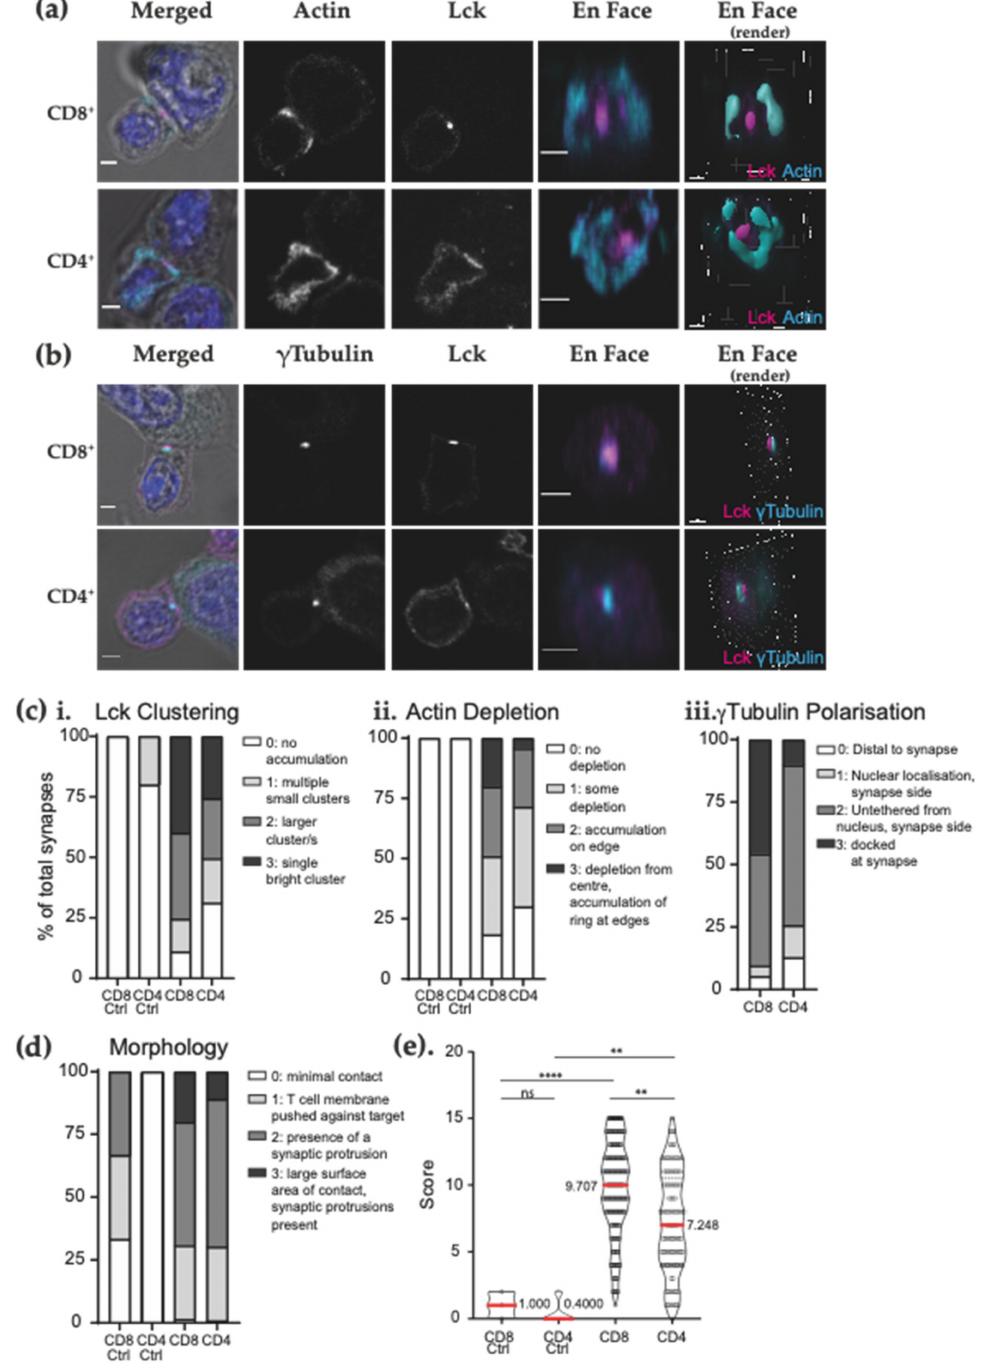
Figure 4. GCT615-CAR T cell target conjugates synapses show topological similarity to physiological immune synapses. CD4 + or CD8 + GCT615-CAR T cells were co-cultured with T2 target cells before fixing, permeabilising and